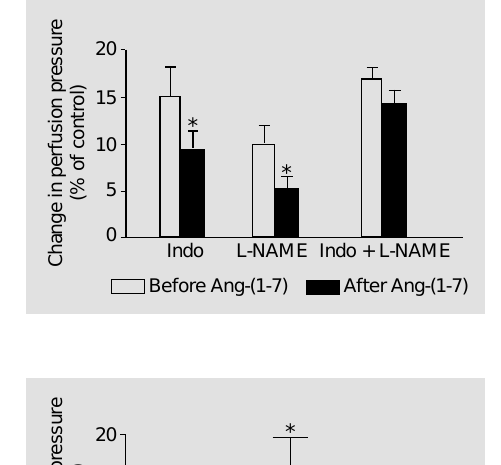
Figure 3 - Effect of A-779 on the bradykinin (BK)-potentiating ac- tivity of Ang-(1-7) in isolated rat hearts. The effect of BK (2.5 ng) was determined before and af- ter perfusion with Ang-(1-7) (2.2 nM) or Ang-(1-7) combined with A-779 (55 nM). *P<0.05 com- pared to BK alone (ANOVA fol- lowed by the Newman-Keuls